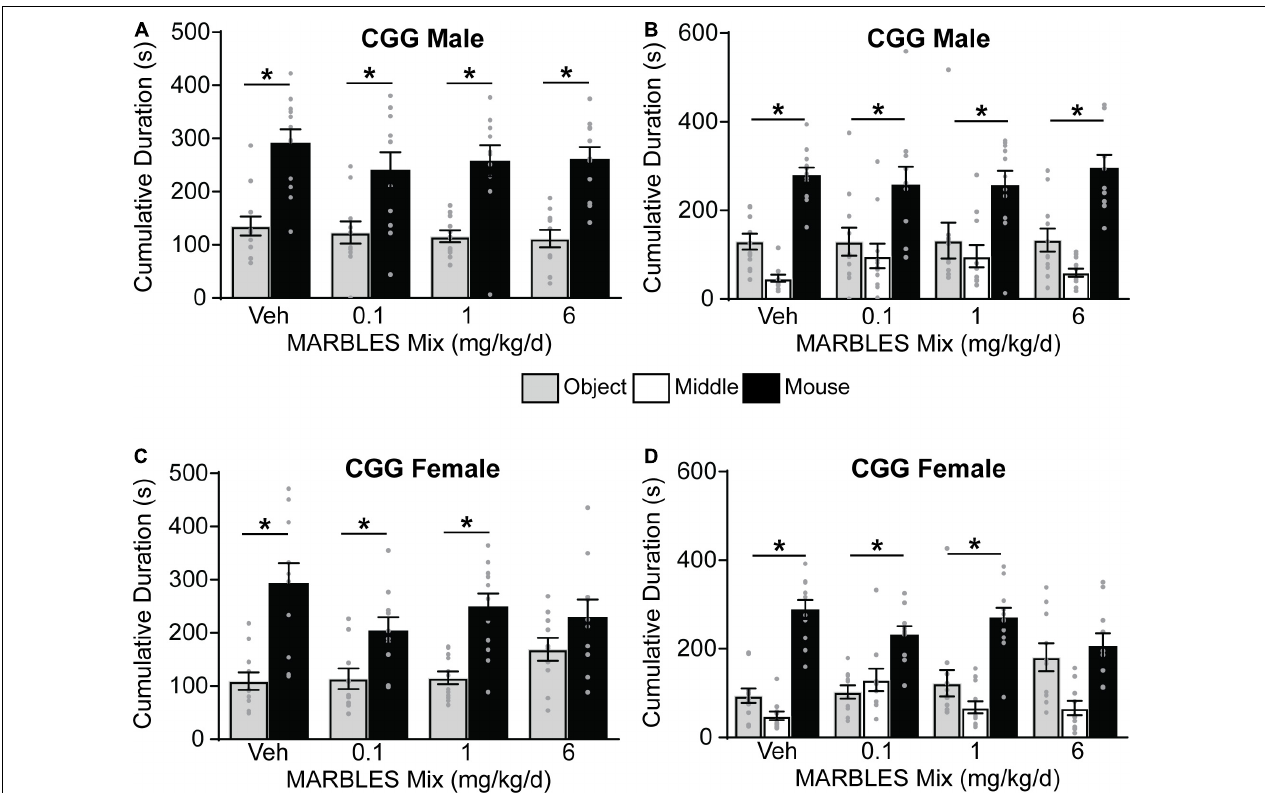
FIGURE 5 | Developmental exposure to MARBLES PCB mix at 6 mg/kg in the maternal diet decreased sociability in female CGG mice. (A,C) The amount of time males (A) or females (C) spent sniffing either a novel sex and age matched mouse or a novel object. (B,D) The amount of time males (B) or females (D) spent on each chamber side. Data presented as mean ± SEM ( n = 10–12). * Indicates significant difference between novel mouse vs. novel object at p < 0.05 as determined using an unpaired t -test, Mann-Whitney test or unpaired t -test with Welch’s